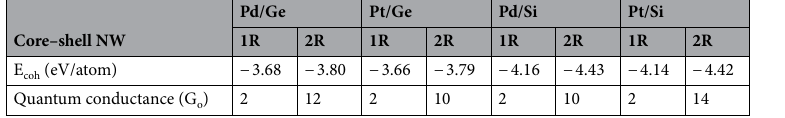
Table 1. Cohesive energy (E coh ) and quantum conductance of the considered core–shell NWs.